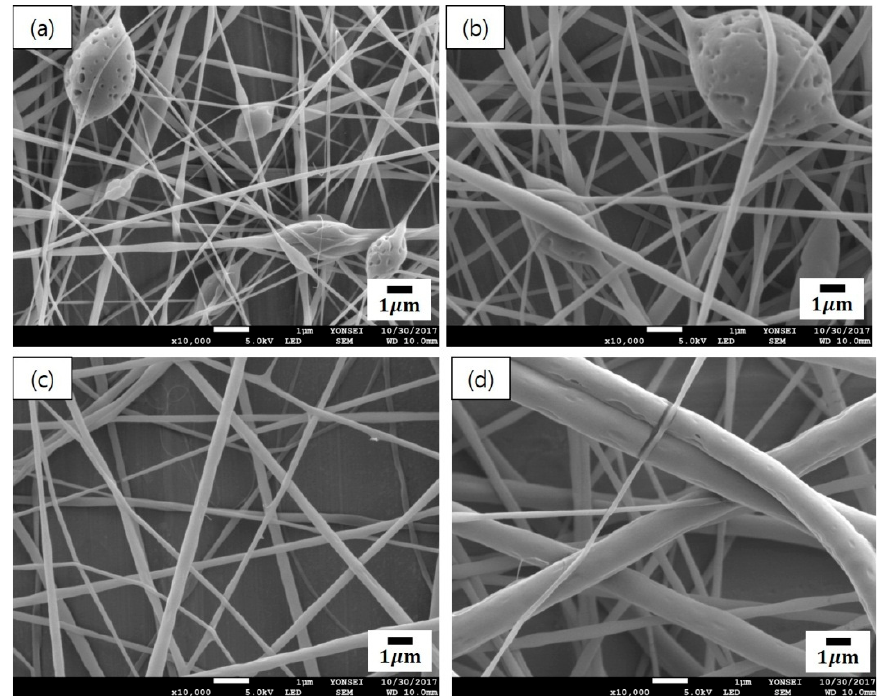
Figure 2. SEM images of cinnamon oil-containing poly(vinyl alcohol) (PVA) nanofibers produced from different emulsion formulations: ( a ) emulsion A (10 wt% of PVA, 3.57 wt% of oil, and 0.71 wt% of surfactant), ( b ) emulsion B (11 wt% of PVA, 3.93 wt% of oil, and 0.79 wt% of surfactant), ( c ) emulsion C (12 wt% of PVA, 4.29 wt% of oil, and 0.86 wt% of surfactant), and ( d ) emulsion D (13 wt% of PVA, 4.64 wt% of oil, and 0.93 wt% of surfactant).